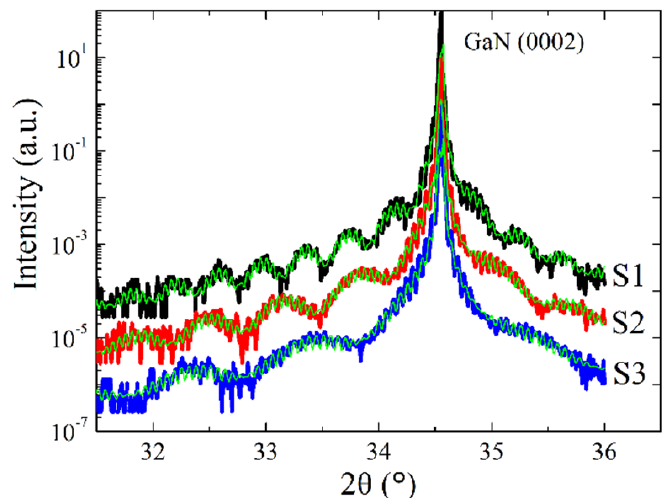
Figure 1. GaN (0002) ω / 2 θ HRXRD scan curves of the three samples. The black, red, and blue thick lines represent the measured ω / 2 θ curves of samples S1, S2, and S3, respectively. The fitted curves, all indicated by the thin green lines, are directly superimposed on their measured ones, respectively.